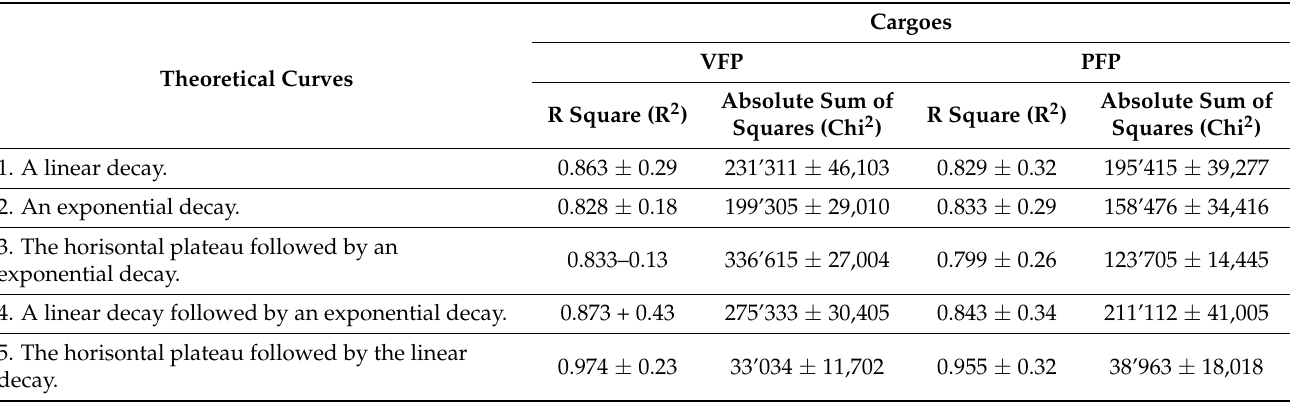
Table 6. Statistical evaluation of the goodness-of-fit of the regression lines obtained after synchroniza- tion of VFP and PFP exit from the GC per